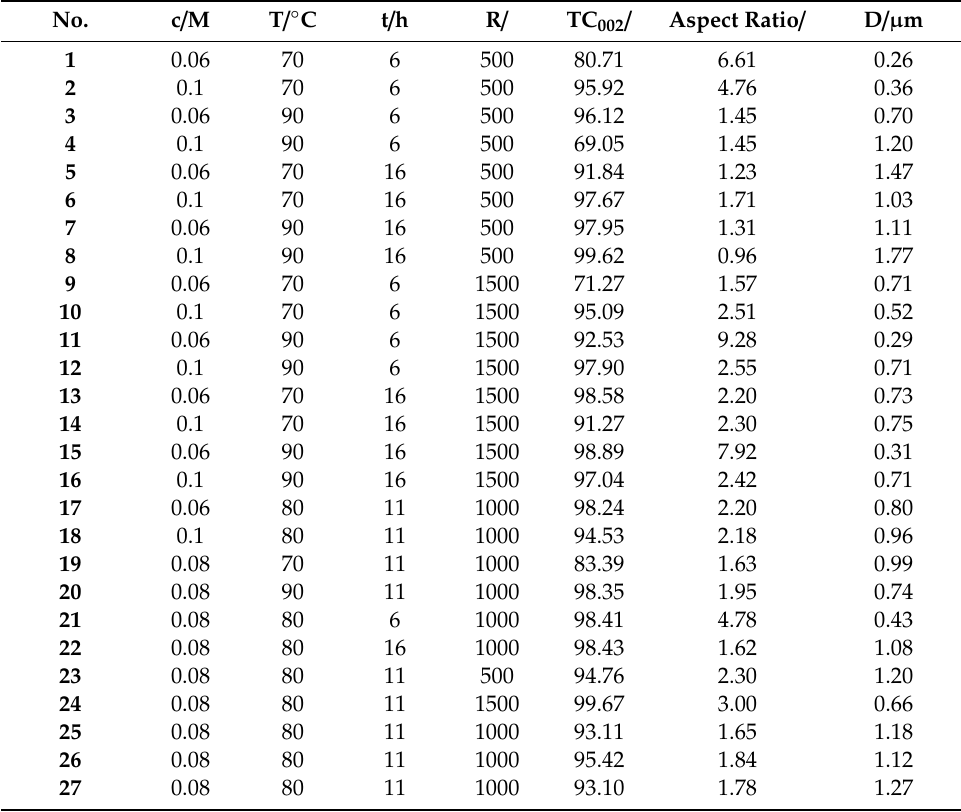
Table 1. Optimization design with detailed factors and the obtained